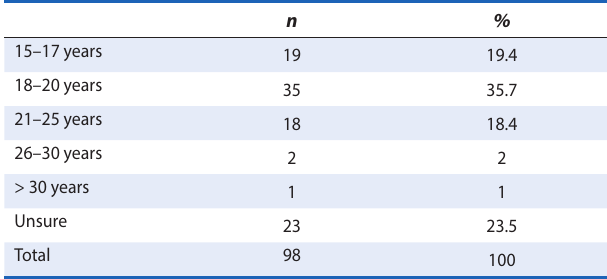
Table 3: Age at first sexual encounter